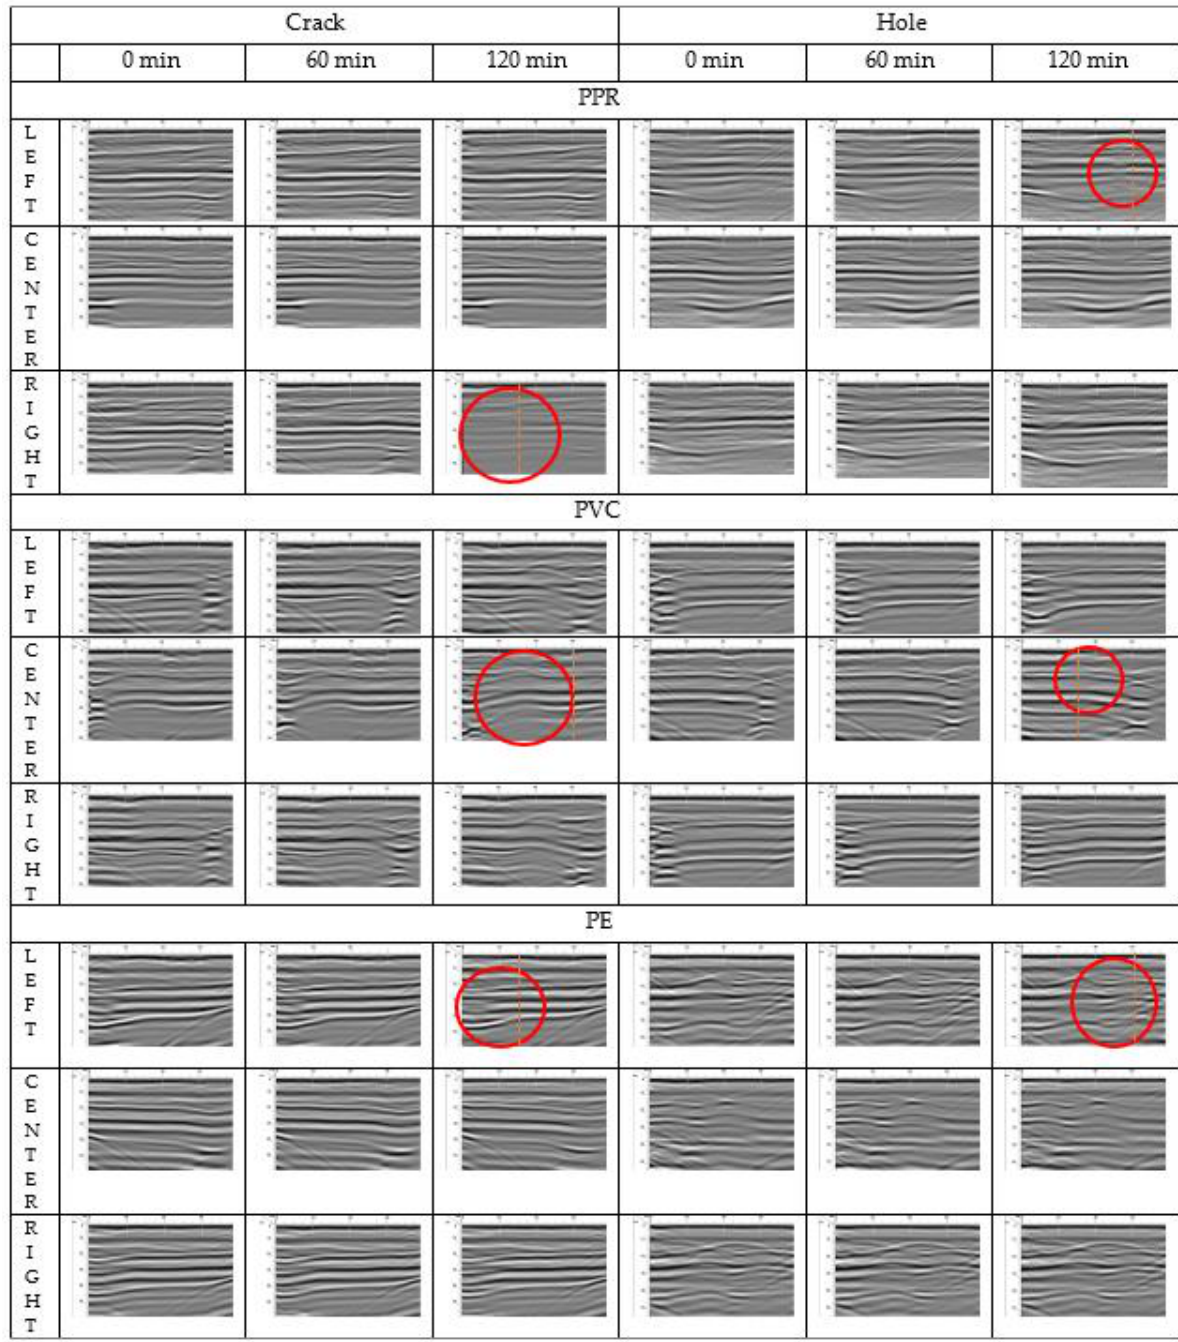
Figure 9. GPR images obtained on PPR, PVC and PE setup with 2% soil moisture content.